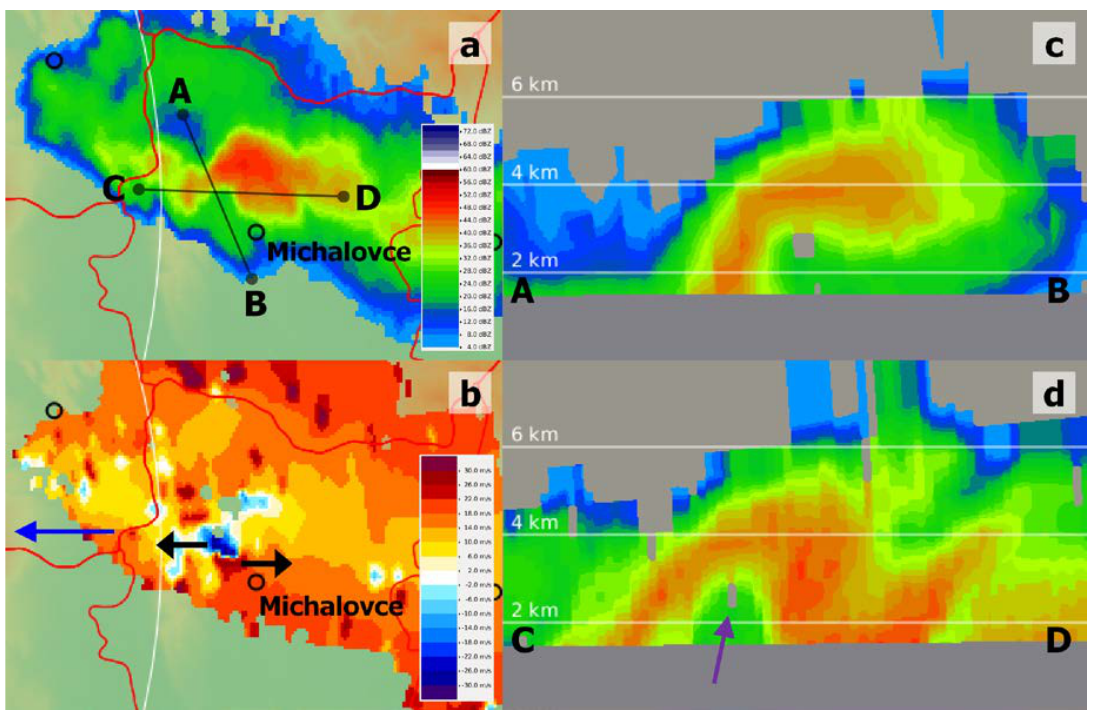
Figure 7. ( a ) Surface weather-station observations on 3 October 2018 12:00 UTC based on synoptic reports and analysis of mean sea-level pressure (hPa). Surface-station plots: T, air temperature (°C); Td, dew-point temperature (°C); MSLP, mean sea-level pressure (hPa); PT, 3-h pressure tendency (10 – 1 hPa); cloudiness represented by circles, and wind by wind barbs. Triangles, automatic weather